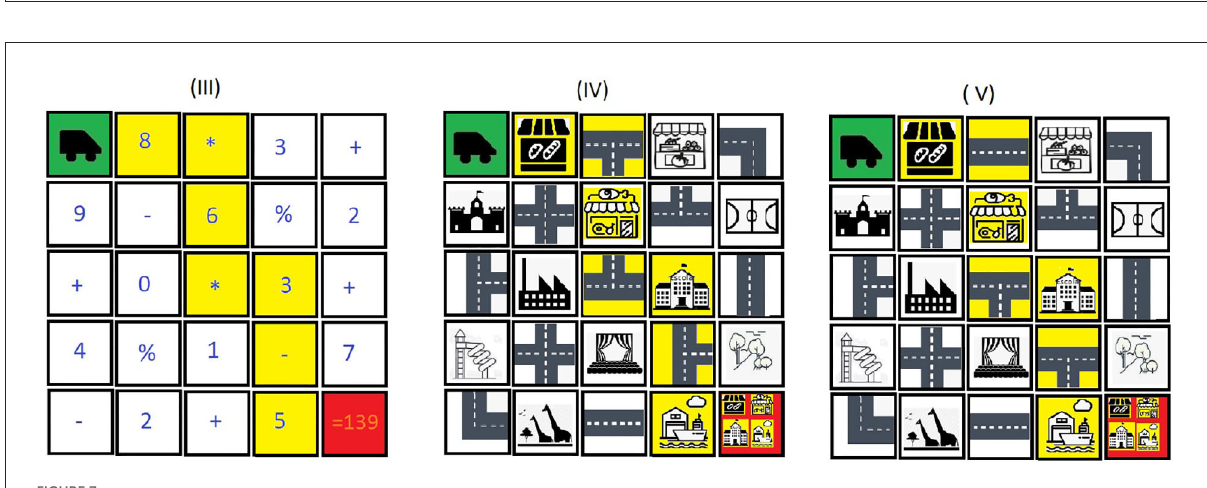
FIGURE7 Different examples where a syntax related to operators is added in example (III) , and a more restricted syntax related to possible pathways is presented in examples (IV) and (V)